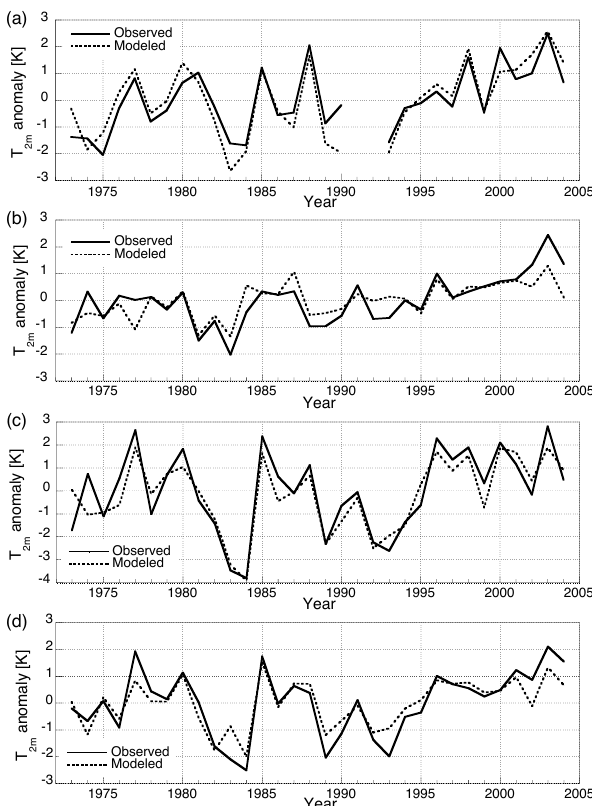
Fig. 5. Comparison of simulated (dashed lines) and observed (solid lines) annual mean 2m temperature anomaly [K] with respect to their mean value (1973–2004) for 4 DMI climate stations at (a) Thule, (b) Tasiilaq, (c) Sondre Stromfjord, and (d) Julianehavn.